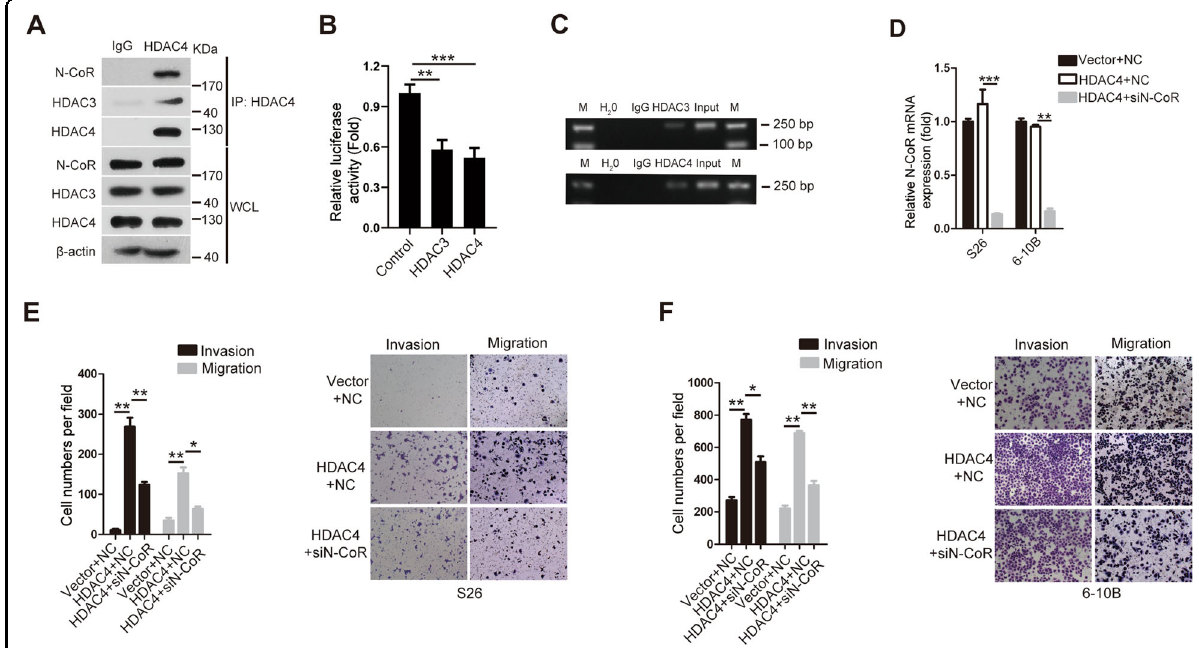
Fig. 4 Knockdown of N-CoR abolishes the effect of HDAC4 on the invasion and migration abilities of NPC cells. A 6-10B cells were harvested for immunoprecipitation using anti-IgG, anti-HDAC4, anti-N-CoR, and anti-HDAC3 antibodies and then were analyzed by western blotting. β -Actin was used as a loading control. Note: HDAC4 associates with endogenous N-CoR and HDAC3. B The luciferase activity of the E-cadherin promoter in 6- 10B cells transfected with HDAC3/4 expression plasmids was determined. The Renilla luciferase vector was used as an internal control. C ChIP assays determined the binding abilities of HDAC3/4 to the E-cadherin promoter regions in 6-10B cells after transfection with HDAC3/4 expression plasmids. D The mRNA level of N-CoR was assessed in the indicated cells by qRT-PCR. GAPDH was used as a loading control. The data are presented as the means ± SD of three independent experiments. Student ’ s t -test, ** P < 0.01, *** P < 0.001. E , F The invasion and migration abilities of the indicated stable cell lines were determined as described in the “ Methods ” section. The right images are the representative images, and the left images are the statistical results. The data are presented as the means ± SD of three independent experiments. Student ’ s t -test, * P < 0.05, ** P <